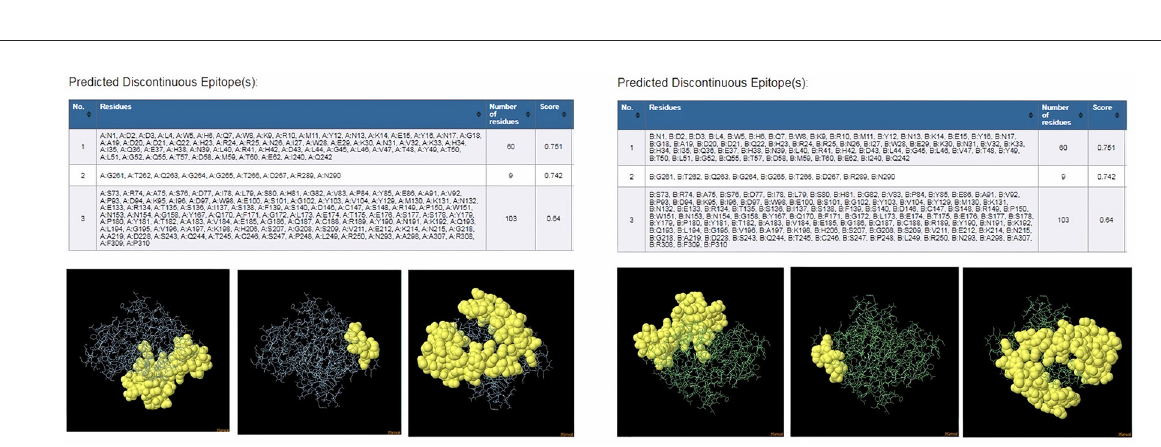
FIGURE9 ElliPro: Discontinuous (conformational) antibody epitope 3D structures prediction of FhCatL1. Crystal Structure of ProCathepsin L1 from Fasciola hepatica (206X.1A) chain A PDB file was used as input data for ElliPro searches. Table of predicted epitopes, and Jmol visualization of the 3 predicted epitopes shows the epitope residues are in yellow and the rest of the protein is in violet (left panel) . Crystal Structure of ProCathepsin L1 from Fasciola hepatica (206X.1B) chain B PDB file was used as input data for ElliPro searches. Table of predicted epitopes, and Jmol visualization of the 3 predicted epitopes shows the epitope residues are in yellow and the rest of the protein is in green (right panel)